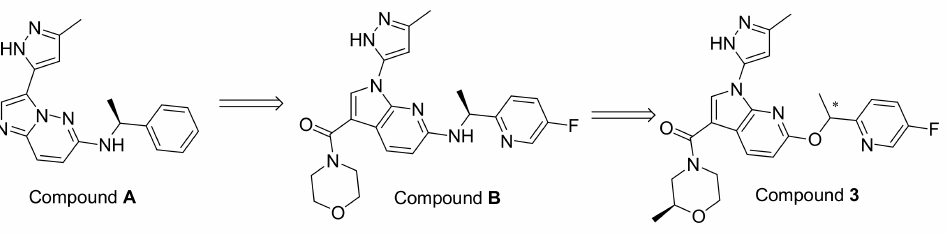
Figure 9. A schematic view of the development of compound 3 and the key changes to structure from the lead